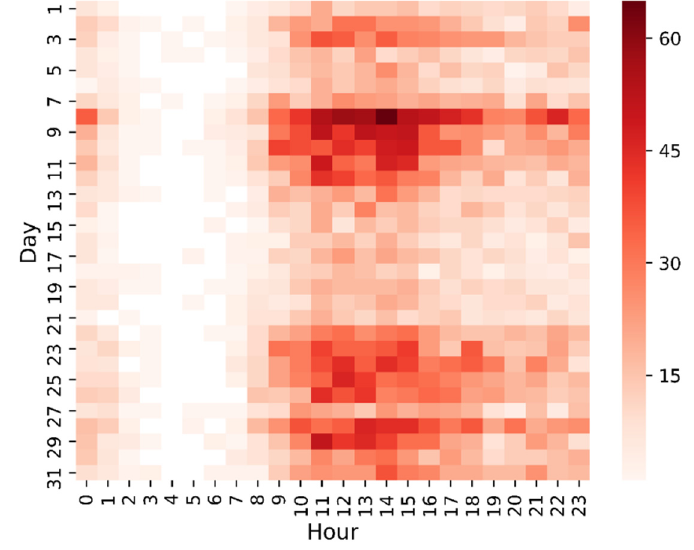
Figure 1. Temporal heatmap of unstable approach (UA) events.